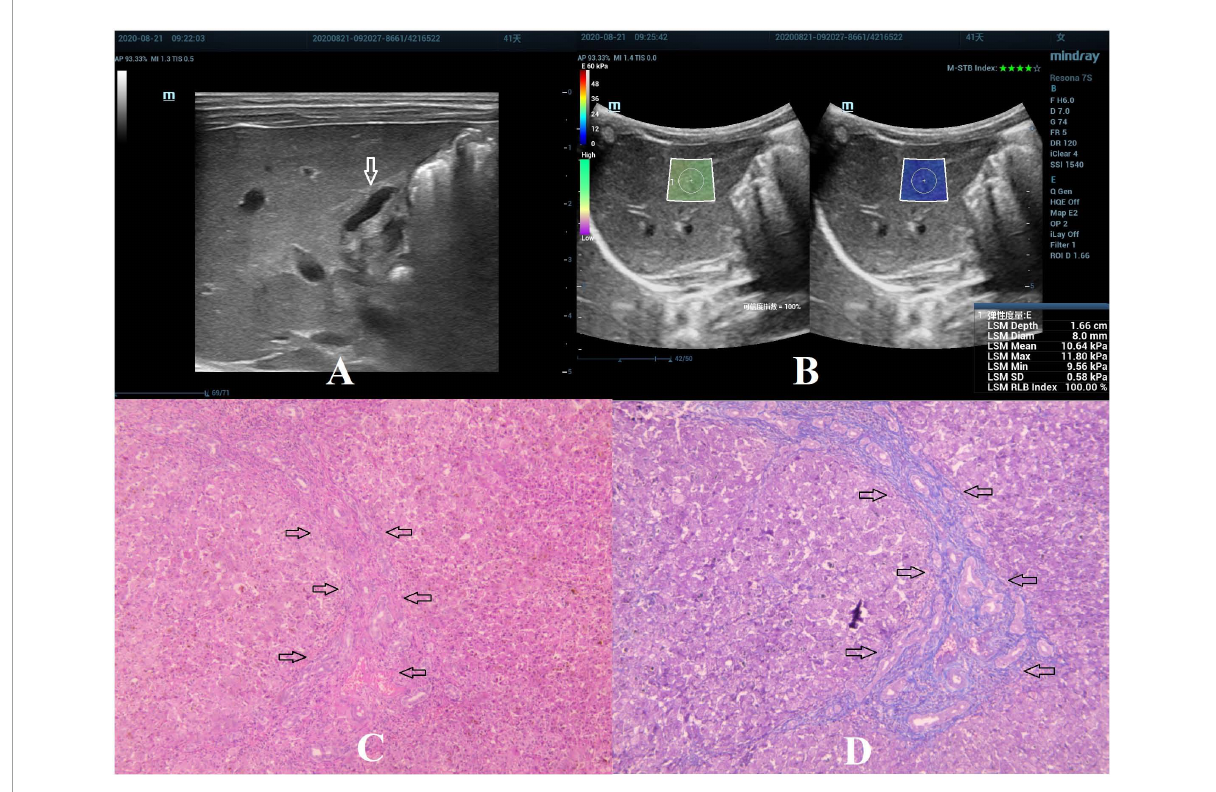
FIGURE2 Biliary atresia in a 41-day-old girl with stage F2 hepatic fibrosis. (A) Arrow indicating the gallbladder abnormality. (B) STE image showing the mean value of liver stiffness of 10.64 Kpa. (C) Hematoxylin and eosin staining (40 × magnification). The structure of the hepatic lobule was visible, the portal area was enlarged, and the bile canaliculi, blood vessels, and fibrous tissue proliferated (as indicated by the arrow). (D) Masson’s trichrome staining (40 × magnification). The portal area was enlarged, and few septa were formed (as indicated by the